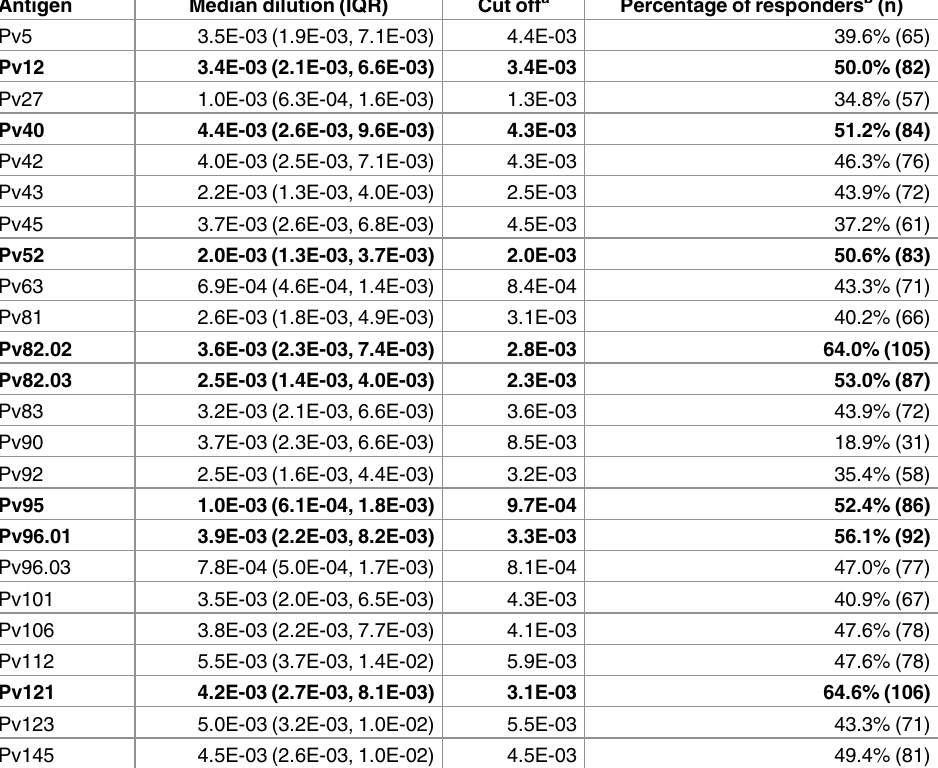
Table 2. Dilution of total IgG response to the different coiled coil